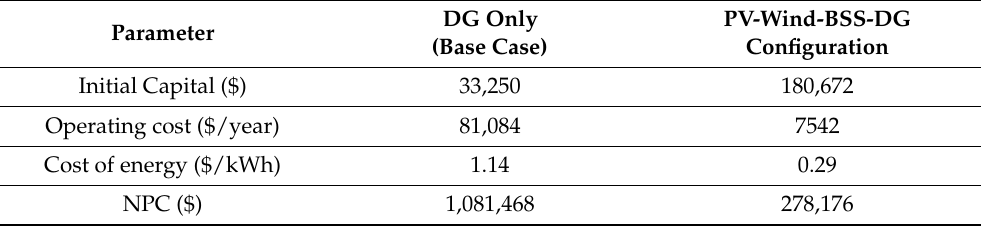
DG Only (Base Case)